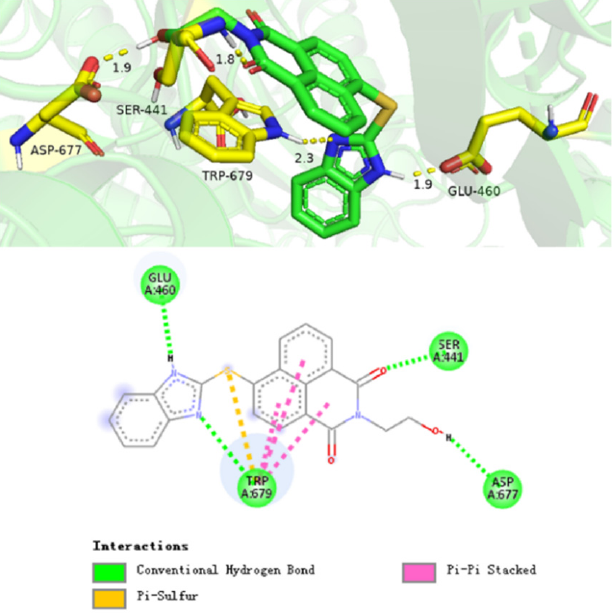
Figure 7. Supramolecular structure of highly active thioether benzimidazole 7f with cytochrome P450 reductase from C. tropicalis .